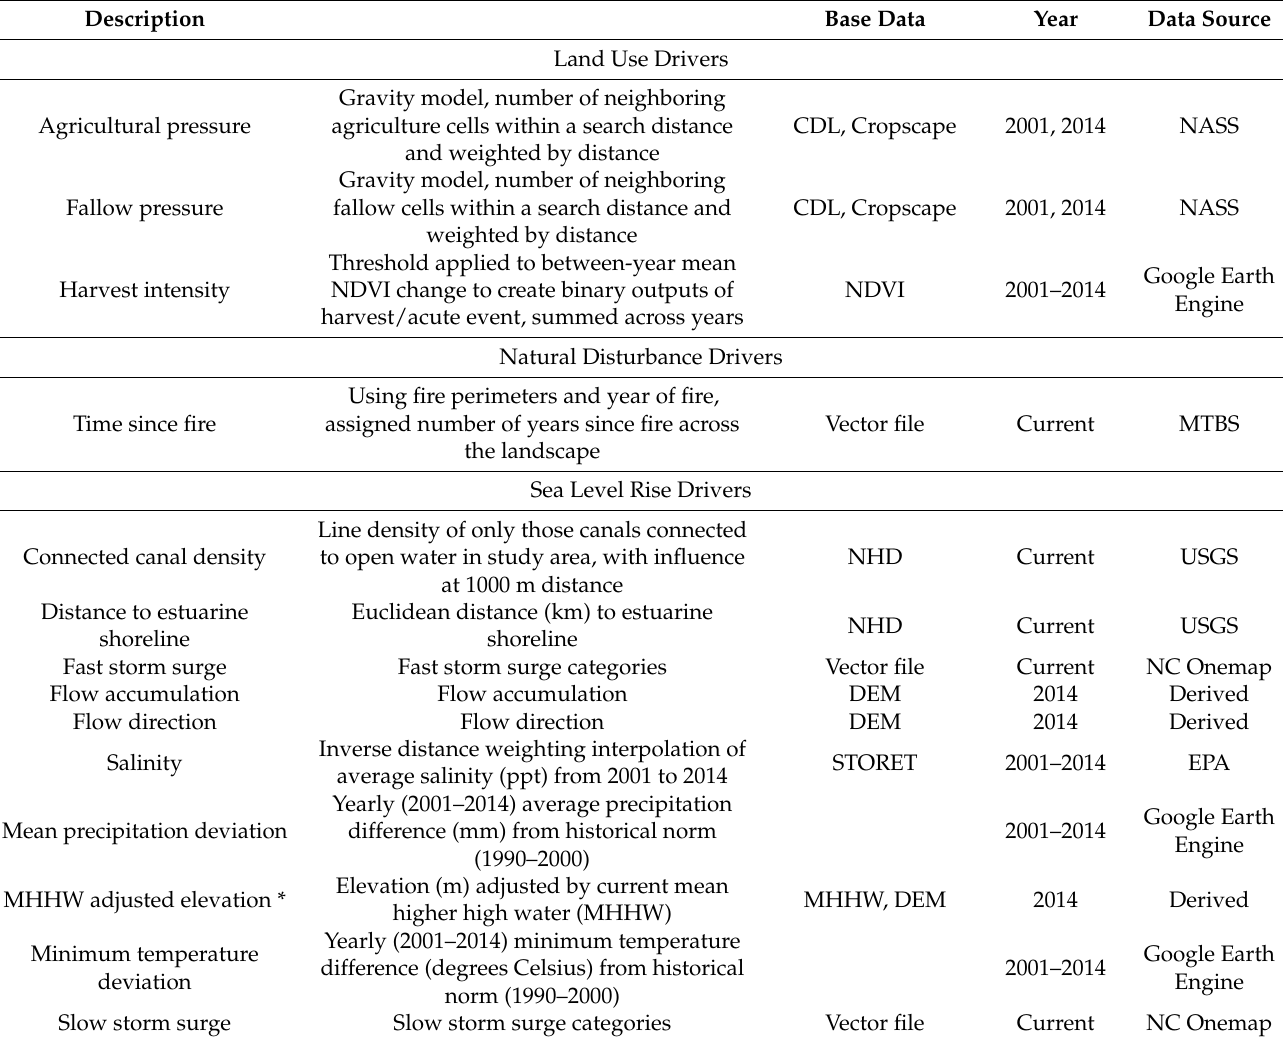
Table 1. Suite of spatially explicit predictor variables explored within the land use, natural disturbance, and sea level rise categories. All variables were developed as 30-m resolution raster datasets and aggregated using a 450 × 450-m